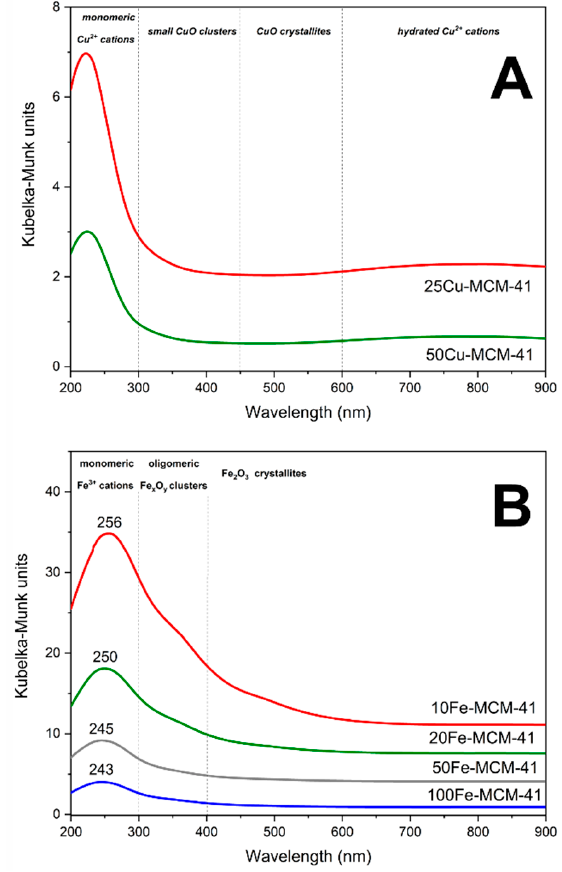
Figure 6. UV-vis-DR spectra of the spherical MCM-41 based samples modified with copper ( A ) and iron ( B ).